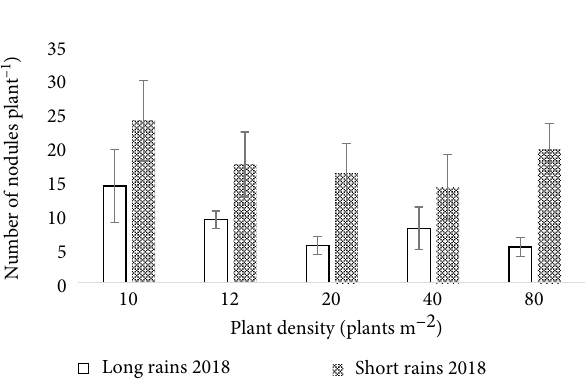
Figure 3: Effect of density and season on transpiration rate at 50% flowering stage. Vertical bars represent ± standard error. Values significantly different at 푝 < 0.05 .